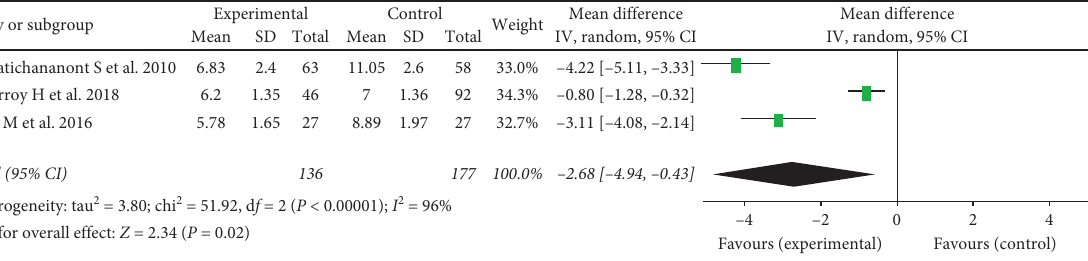
Figure 5: Forest plot of the Total Mucosal Visibility Score (McNally) between simethicone premedication agent and control.